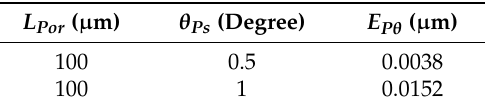
Table 2. Error of PSD setup.